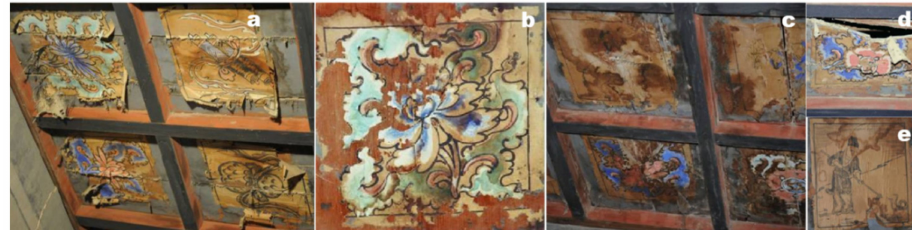
Figure 2. Deterioration of Caisson Paintings. ( a ) Falling off; ( b ) missing; ( c ) pollution; ( d ) plank cracking; ( e )